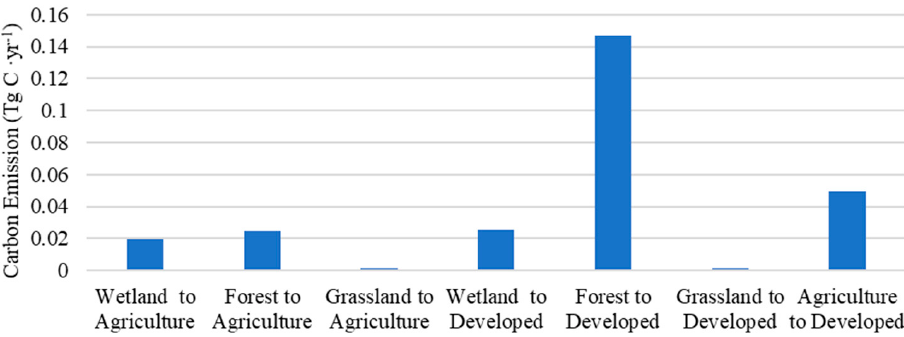
Figure 6. Comparison of ratio of total ecosystem carbon storage (TEC) in different scenarios. (a) Ratio of TEC in scenario LULCC of 2011 and initial TEC of 2001; (b) ratio of TEC in scenario without LULCC of 2011 and initial TEC of 2001; (c) ratio of TEC in scenario LULCC of 2011 and TEC in scenario of LULCC in 2011; (d), (e) and (f) are zoomed-in figures of interest areas in black squares, respectively, of (a), (b), and (c).